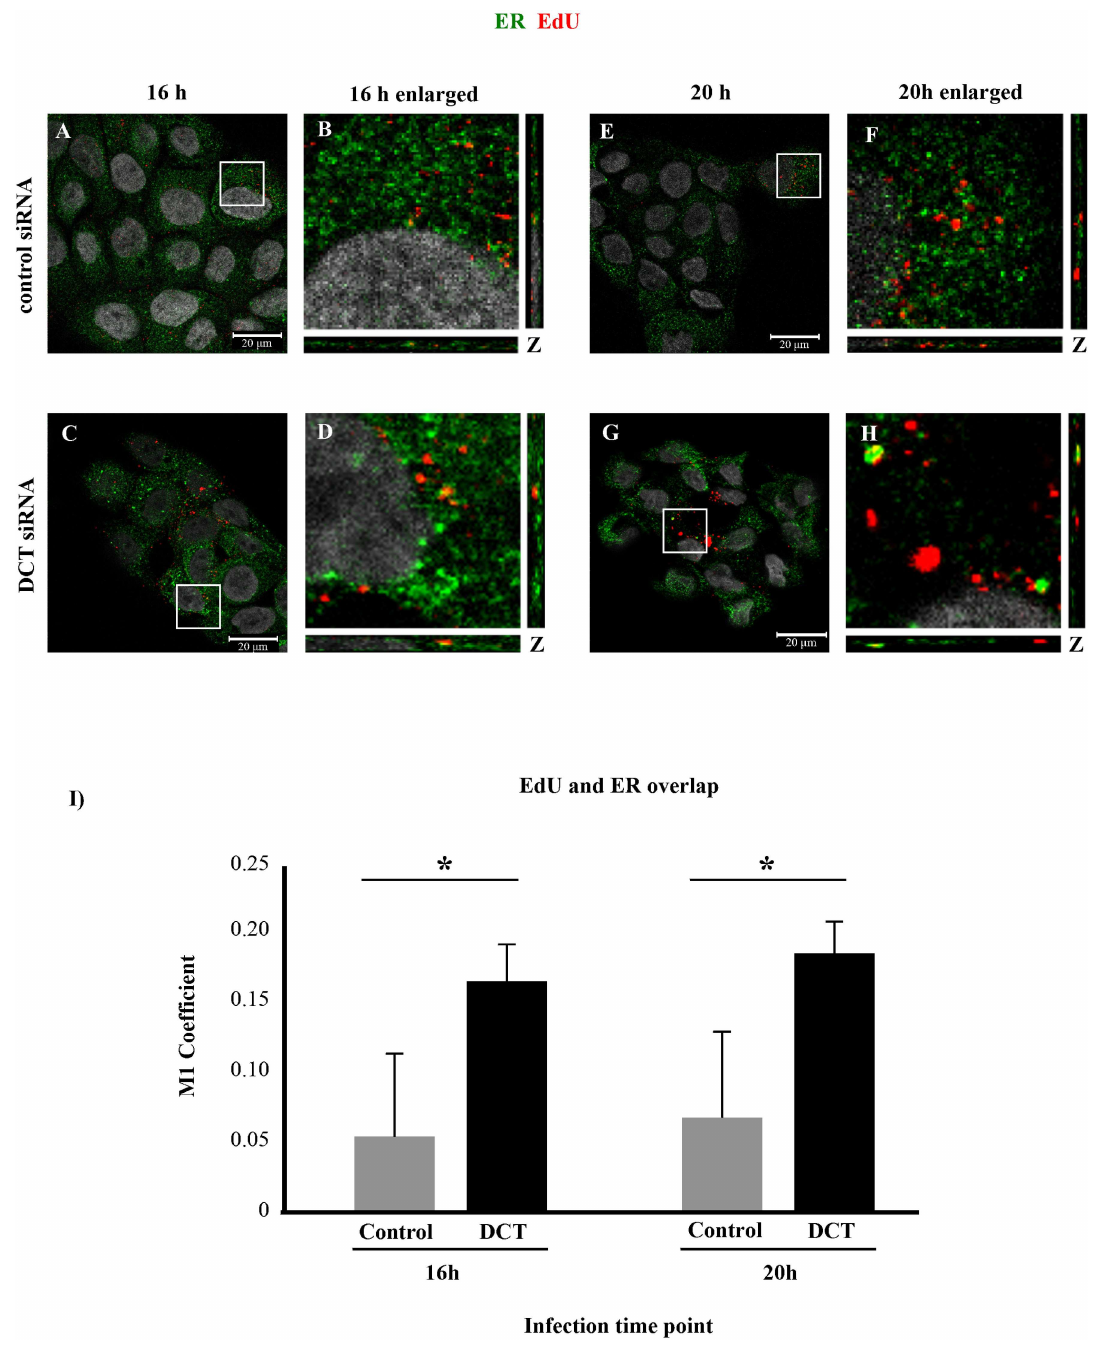
Fig 4. DCT knockdown causes increasedER trafficking of EdU-labeled pseudogenome. DCT or control siRNA treated cells were infected with HPV16 PsV harboringEdU-labeled pseudogenome for 16 h (A-D) or 20 h (E-H). ER was stainedwith BiP (green), EdU-labeledpseudogenomewas visualized by Click-it reaction (red) and the nucleiwere stainedwith DAPI (grey). (A-D and I) ControlsiRNA treated HaCaTs showedalmost no colocalization, whilesignificantly higherlevels of colocalization was observed in DCT siRNA treated cells at 16hpi (one-tailedt-test p = 0.015). (E-H) At 20hpi,the levels of colocalization were still significantly higher in DCT siRNA treated cells comparedto control cells (one-tailedt-test p = 0.018). (I) M1 coefficient, percentageof red signal(EdU-labeled pseudogenome) overlapping with green signal (BiP) was calculated with the help of JaCOP plug in with nine confocalscans for each condition. (A-H). Error bars show the standard deviationin measurements from three